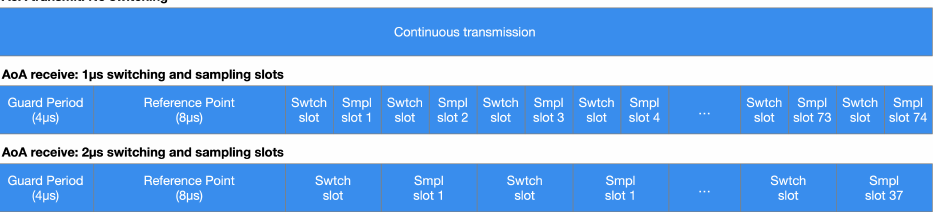
Figure 13. This example represents 1 µ s and 2 µ s timing switching and sampling in an AoA context. The broadcasting device, equipped with a unique antenna, continuously sends data with CTE while the receiving one performs IQ sampling according to a switching and sampling